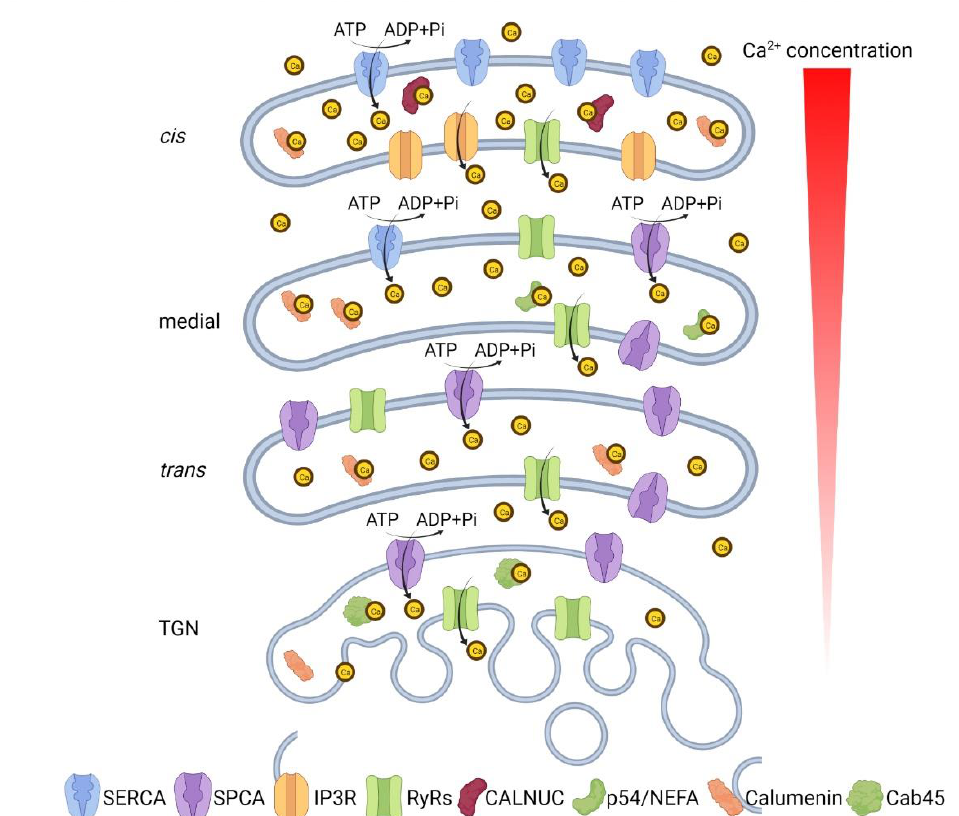
Figure 1. Ca 2+ concentration and Ca 2+ homeostasis-related molecules in different Golgi sub- compartments. The cis -Golgi expresses mainly SERCA and IP3Rs and contains around 250 µM lumenal Ca 2+ ; the medial Golgi mainly expresses SERCA and SPCA1; and the trans- Golgi mainly expresses SPCA1 and RyRs, with a lumenal Ca 2+ of about 130 µM.